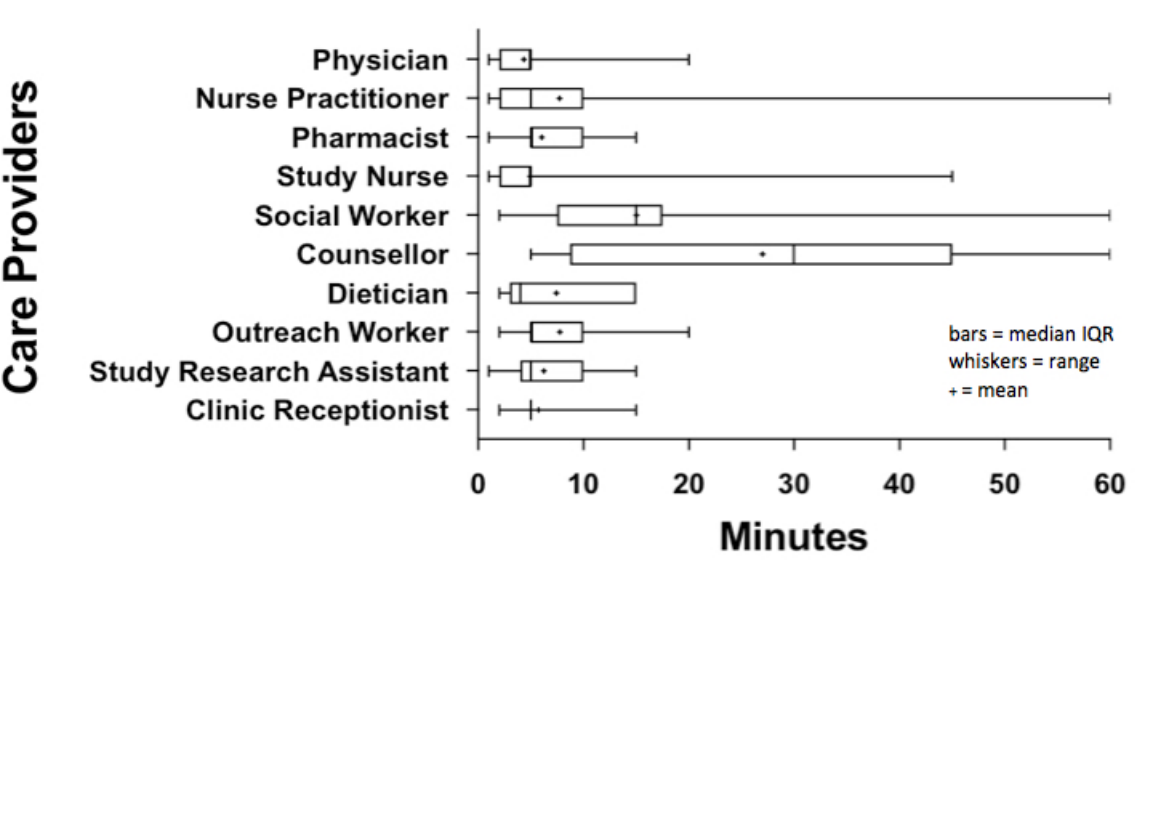
Figure 3. Total amount of health care provider time per